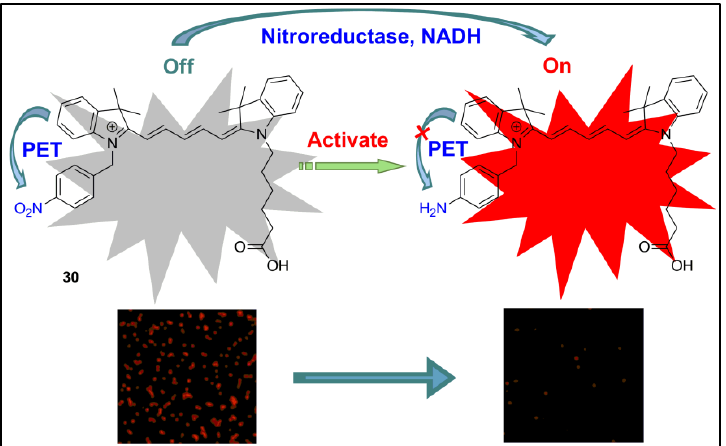
Figure 29. Design strategy of probe 30 for the detection of NTR. Confocal images of Methicillin- resistant Staphylococcus aureus (MRSA) incubated with probe 30 (10 μ M) in the absence (left image) or presence (right image) of NTR inhibitor (dicoumarin — 0.1 mM), λ EX =633 nm and λ EM =700 ± 50 nm. Adapted with permission from [102]. Copyright (2019) Elsevier.